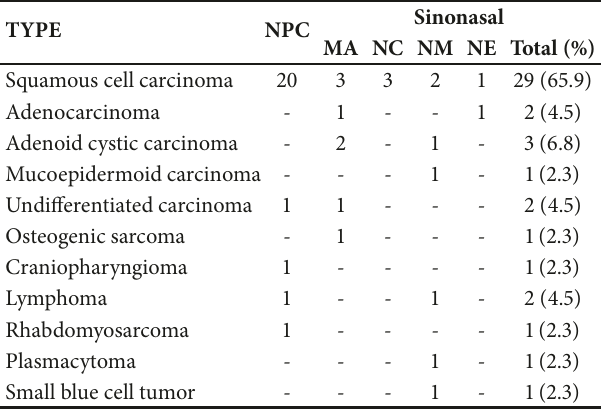
Table 5: Histopathologic